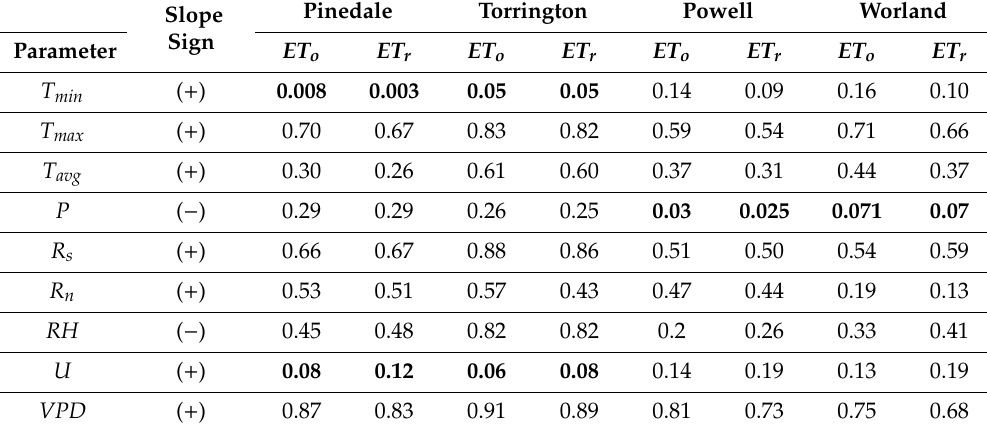
Coe ffi cient of determination (R 2 ) observed between grass and alfalfa reference evapotranspiration (annual ET o and ET r ) and climate variables. T min , T max , and T avg =